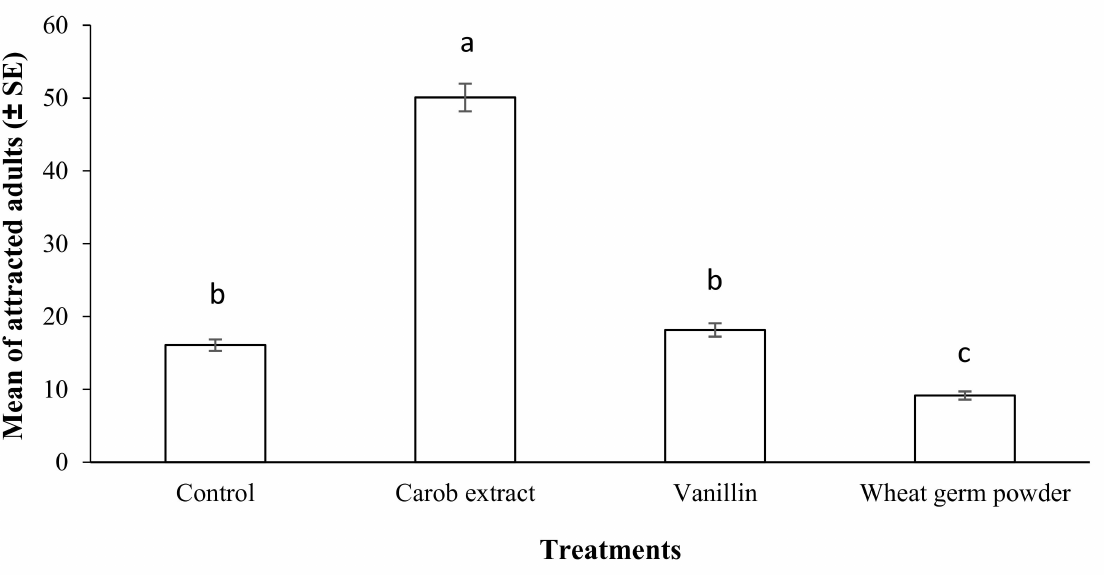
Figure 7. Mean number of adult Sitophilus oryzae attracted to each food attractant compared to control after a period of 12 h in a continuous-airflow multiple-choice olfactometer. Means followed by different letters in each column are significantly different ( p < 0.05, Tukey’s Test).